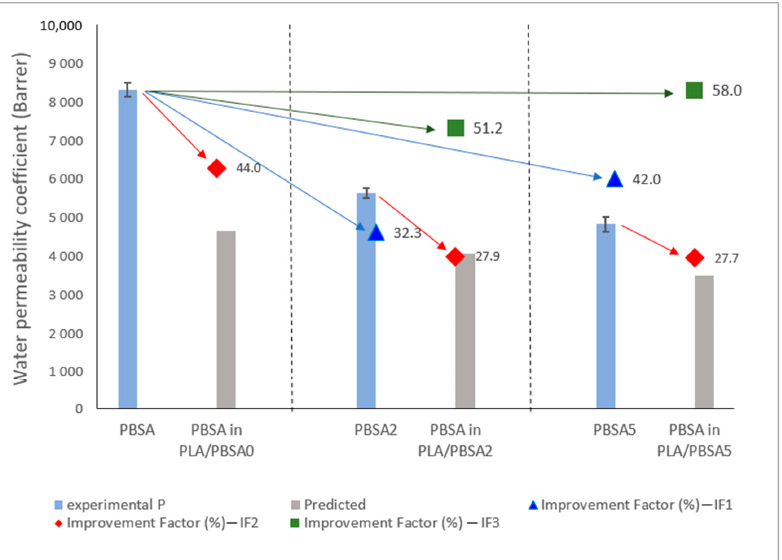
Figure 10. Comparison of the experimental and predicted permeabilities of PBSA under monolayer and multilayer films. IF1: calculated from neat PBSA—effect of loading IF2: calculated from PBSA (neat of filled)—effect of multilayer IF3: calculated from neat PBSA—effect of loading and multilayer.